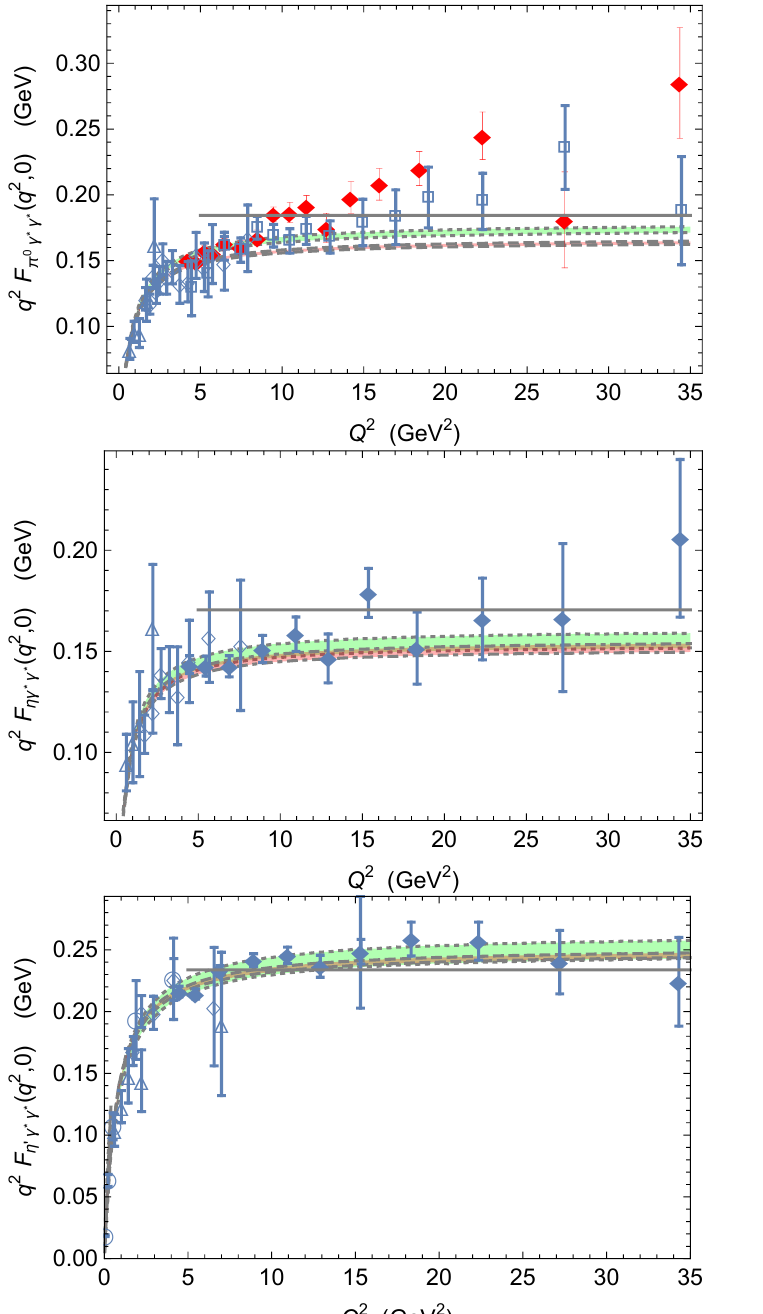
Figure 5 . Comparison between the (cid:25) 0 (top), (cid:17) (middle) and (cid:17) 0 (bottom) TFFs from the (cid:12)t with M V and e V (cid:12)xed (darker red band with dashed borders) and with these parameters included in m the (cid:12)t (clearer green band with dotted borders). BaBar (cid:25) 0 data is not (cid:12)tted in both cases. The remaining notation is the same as in (cid:12)gure